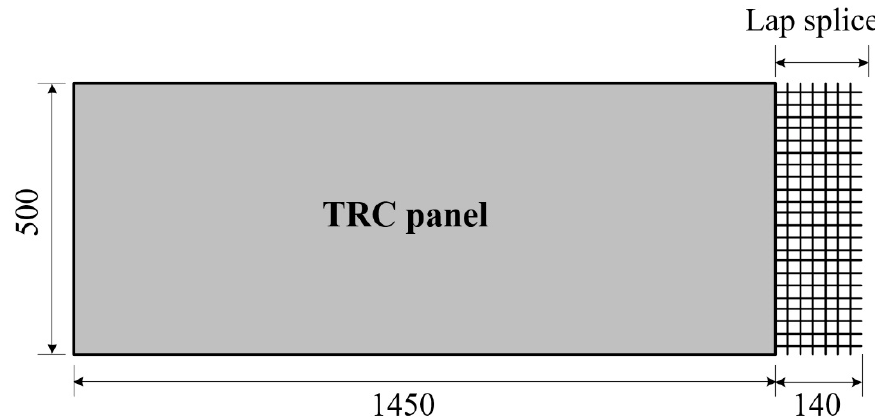
Figure 11. Precast lap-spliced TRC panel (unit: mm).